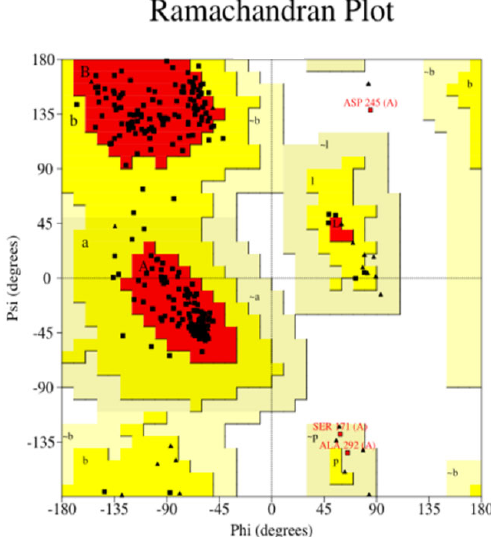
Figure 6. The Ramachandran plot of the SMG1 WT. Residues in generously allowed regions (A292, S171) and disallowed regions (D245) are labeled in red squares (PDB code 3UUE). The plot was downloaded from the Procheck server accessed on 5 November 2021 (https://www.ebi.ac.uk/thornton-srv/software/PROCHECK/). Areas in red, yellow, light yellow and white represented most favored regions, additional allowed regions, generously allowed regions, and disallowed regions, respectively. Black triangles, black squares and red squares indicate glycine, residues except glycine, and residues in generously allowed or disallowed regions.